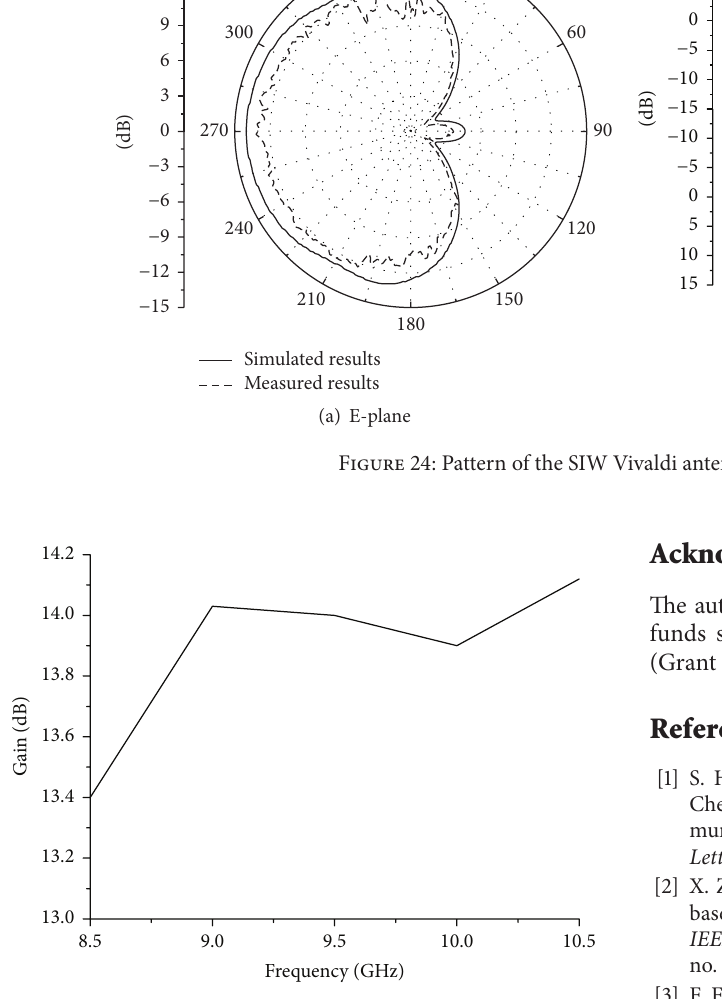
Figure 25 is the simulated gain in operating band. It is shown that the gain is increased with frequency